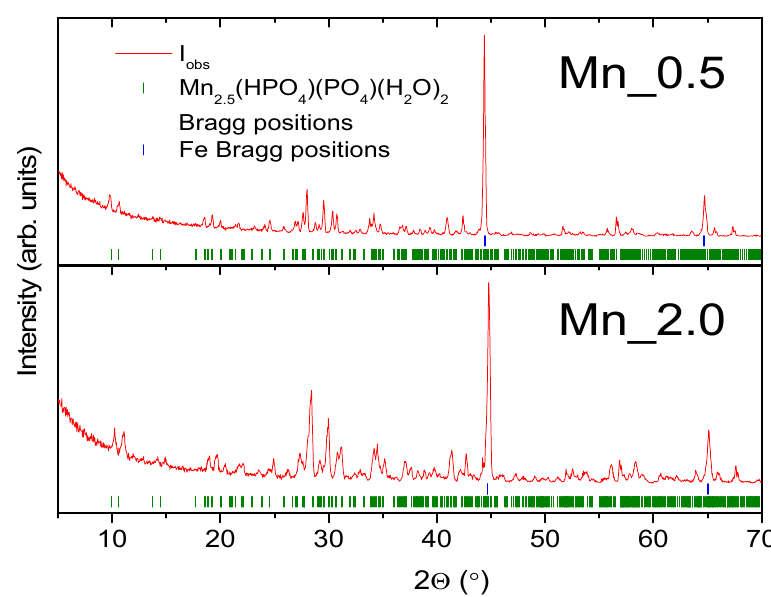
Figure 11. XRD patterns for the samples Mn_0.5 and Mn_2.0. Solid red lines are measured patterns, the green tickmarks correspond to Mn 2.5 (HPO 4 )(PO 4 )(H 2 O) 2 phase, and the blue tickmarks correspond to iron.